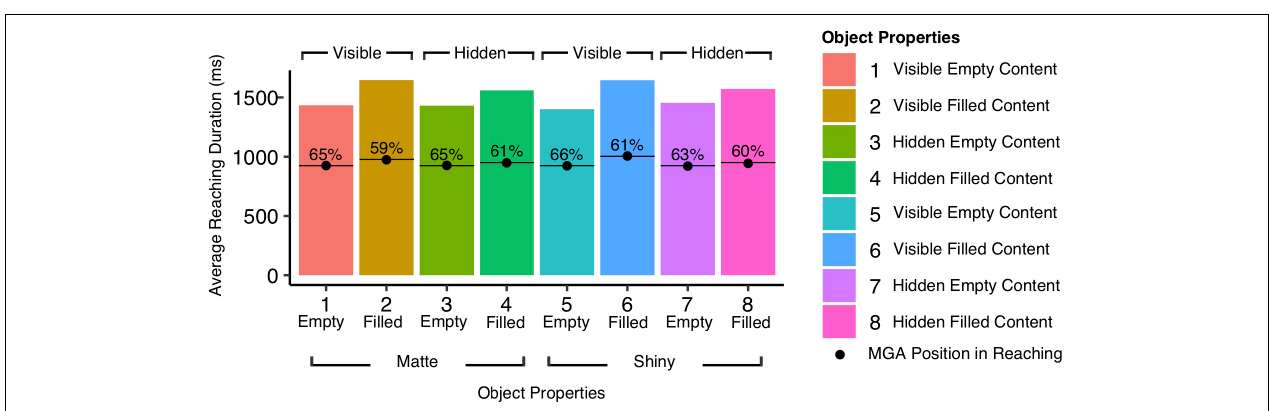
FIGURE 4 | Average adjustment times (ms) in reaching for each block of trials ( N = 5) based on the cups content and surface appearance (material). Both variables, the weight of the cups and the surface gloss, had significant effect on the adjustment times during the first block of trials, and the last block of trials. The participants adopted longer adjustment times when reaching for cups with either matte appearance, or were filled with liquid (heavier). No significant effect was found for the feedback condition, indicating no difference in adjustment times when reaching for cups with or without lid.